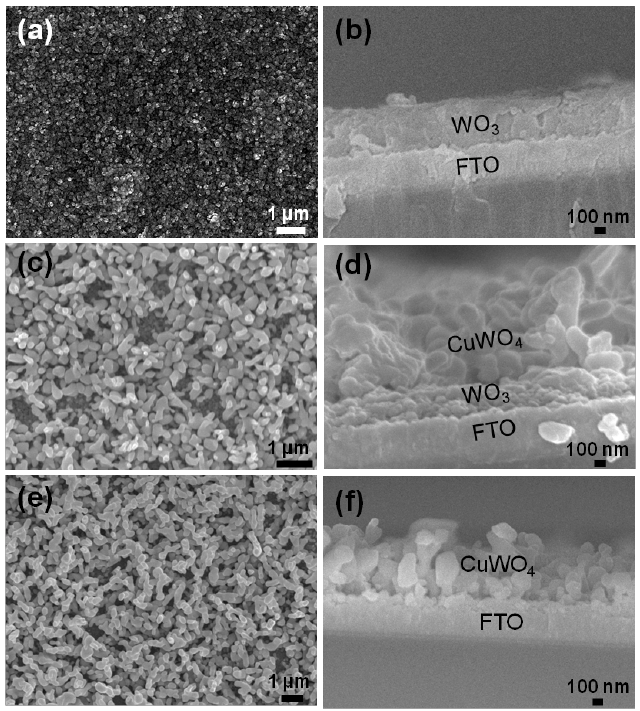
Figure 2. FESEM images of top and cross-section views of WO 3 ( a , b ); WO 3 /CuWO 4 composite ( c , d ) and CuWO 4 ( e , f ) thin films. Table 1. Summary of the thickness of the WO 3 and CuWO 4 layers of the three samples.